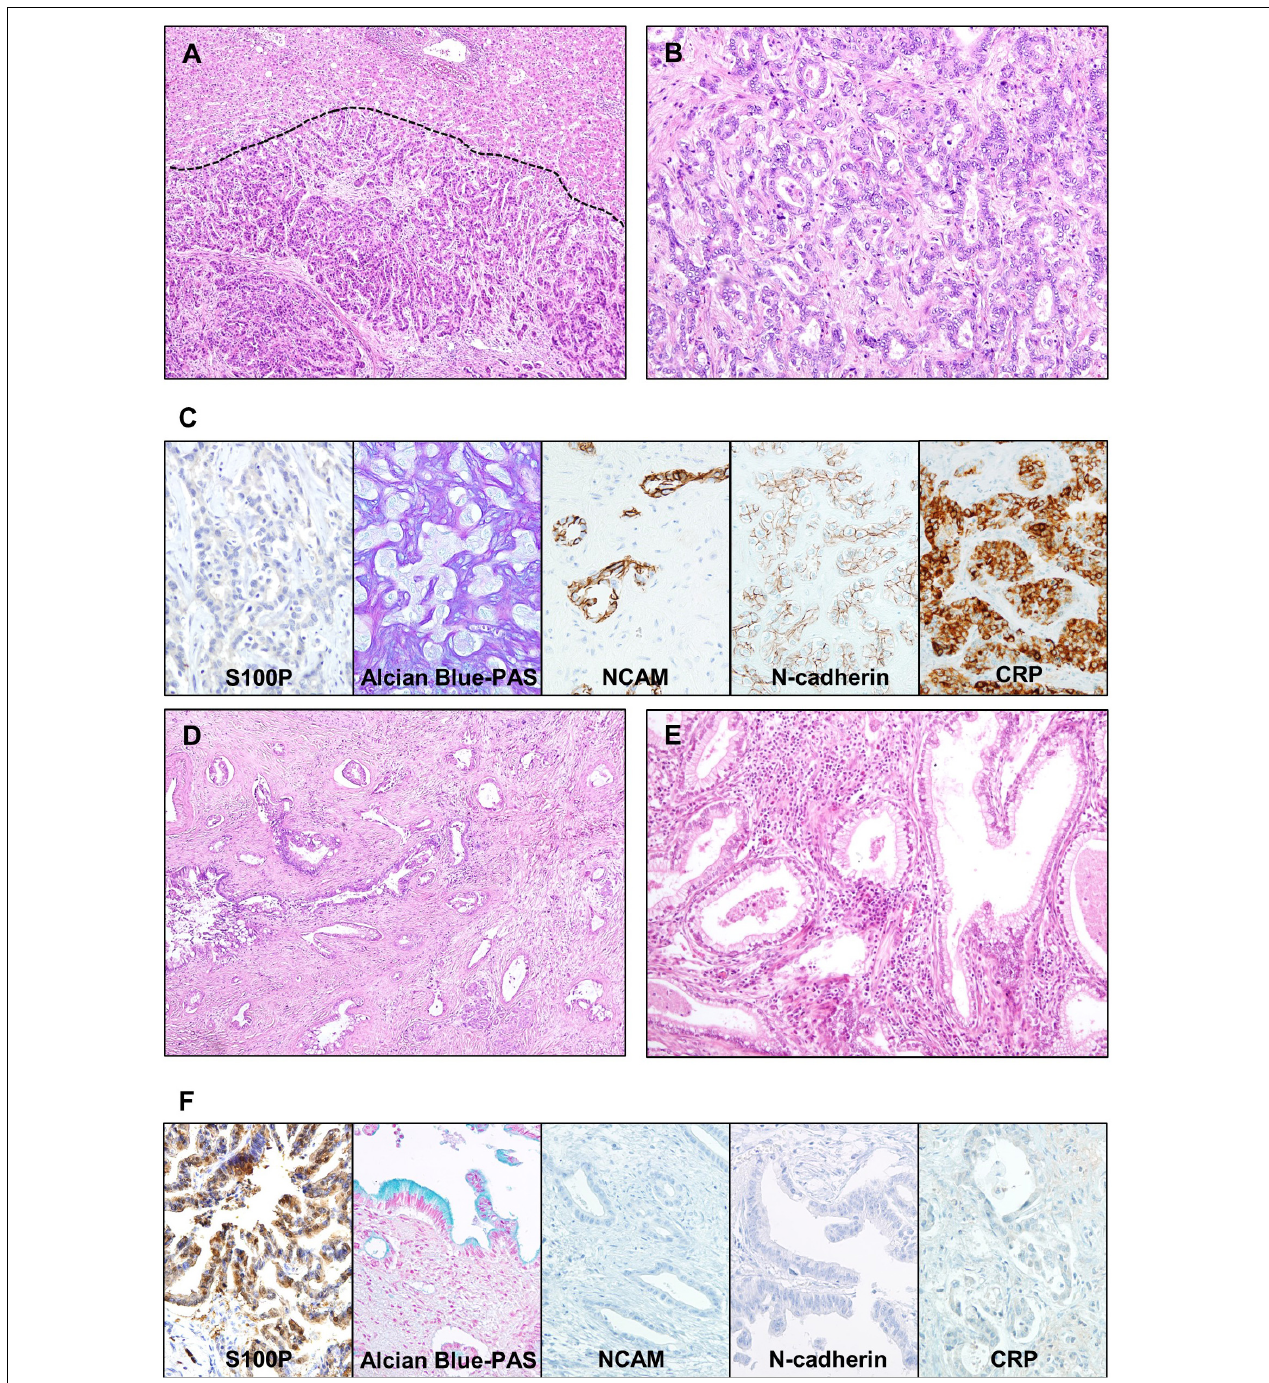
FIGURE 2 | Representative microscopic images of small duct type and large duct type intrahepatic cholangiocarcinoma (iCCA). (A–C) Small duct type iCCA. (A) A low-power view showing uniform-shaped tumor glands replacing hepatocellular trabeculae at the border (indicated by dashed line). (B) A higher magnification image showing the growth of cuboidal cells forming cords and small glandular structures, without intra- or extracellular mucin. (C) Microscopic images of special and immunohistochemical panel staining for small duct type iCCA; positive expression of NCAM, N-cadherin and CRP, negative expression of S100P, and absence of mucin in the Alcian blue staining is characteristic. (D–F) Large duct type iCCA. (D) A low magnification image shows infiltrative growth of adenocarcinoma with rich fibrous stroma. (E) A higher magnification image showing columnar cells with intracellular mucin forming irregular glandular spaces. (F) Microscopic images of special and immunohistochemical panel staining for large duct type iCCA; positive expression of S100P, presence of mucin in the Alcian blue staining, and negative expression of NCAM, N-cadherin, and CRP is characteristic. Original magnification: 40 × for (A,D) , 100 × for (B,E) , 200 × for (C,F) . S100P, S100 calcium-binding protein P; NCAM, neural cell adhesion molecule; CRP, c-reactive protein; PAS, periodic acid–Schiff.